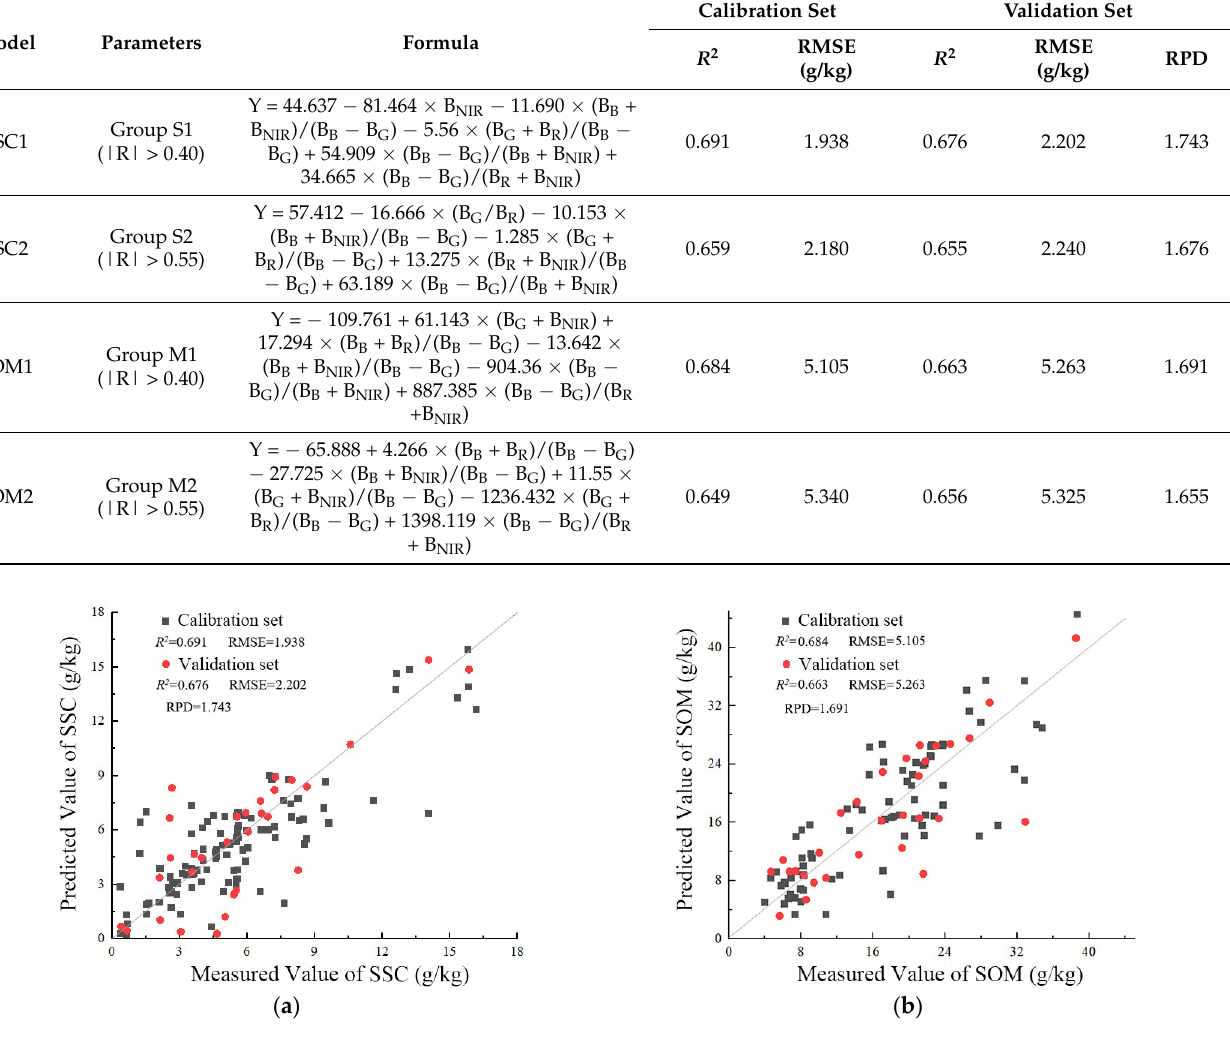
Figure 5. Scatter diagram of the ( a ) SSC1 and ( b ) SOM1 model.